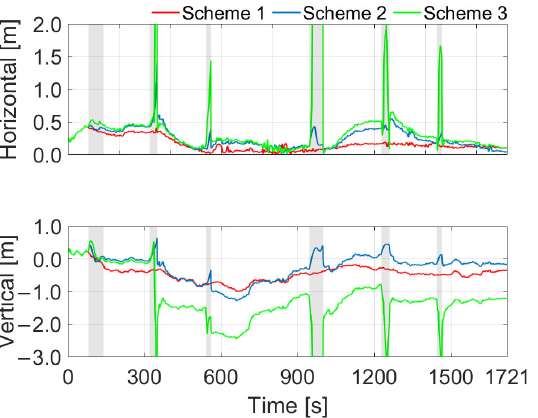
Figure 7. Impacts of the LOS multipath and NLOS reception errors on the positioning solutions.